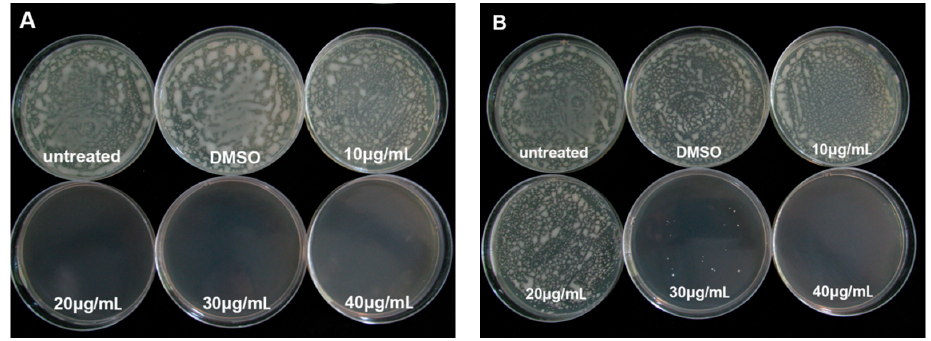
Figure 1. Effect of PCA on the growth of R. solanacearum after cultured for 48 h ( A ) and 96 h ( B ).